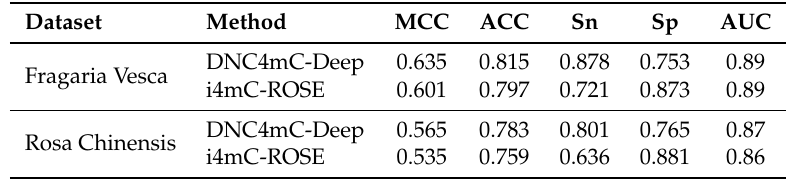
Table 6. Performance evaluation between the DNC4mC-Deep and state-of-the-art model on independent benchmark dataset for F. vesca and R. chinensis species.